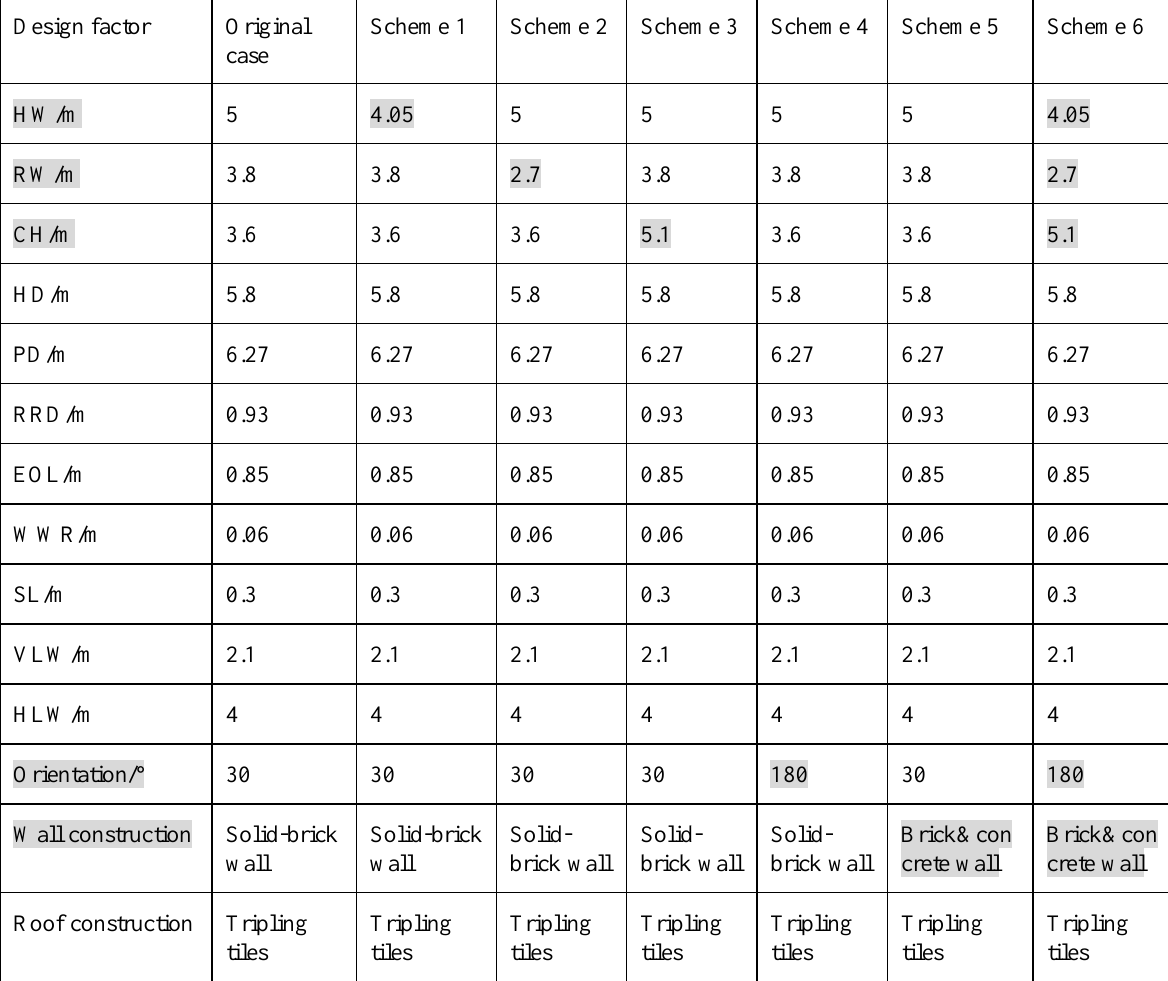
Table 9. The design parameters of new rural house for original and new